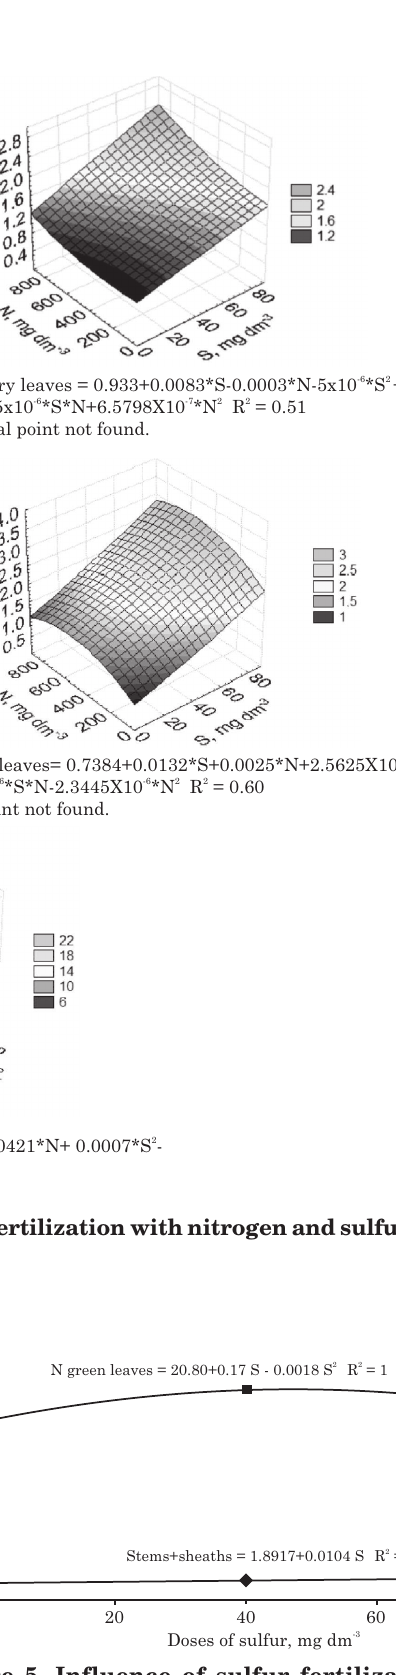
Figure 4. Influence of nitrogen fertilization on dry mass (DM) of dry leaves of Brachiaria decumbens